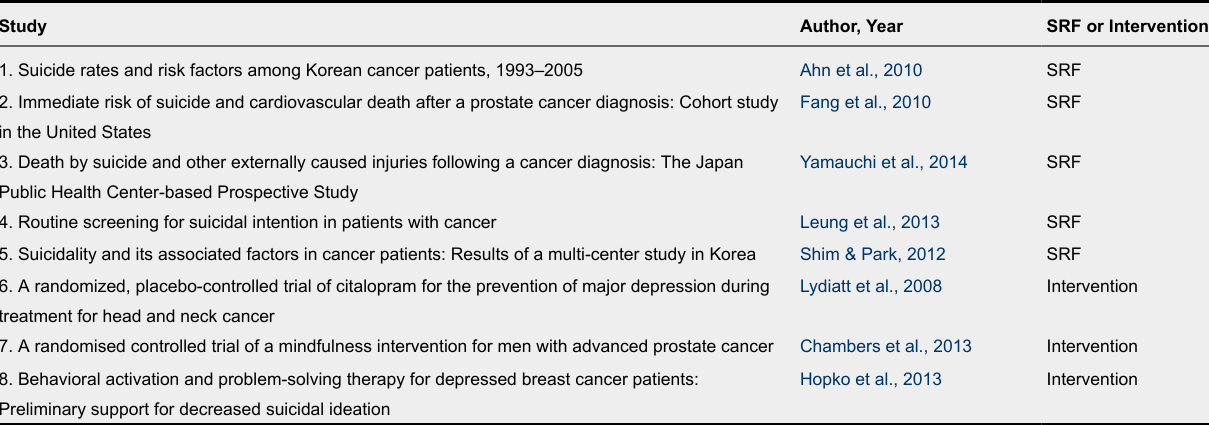
Selected Articles on Suicide Prevention Meeting the Eligibility